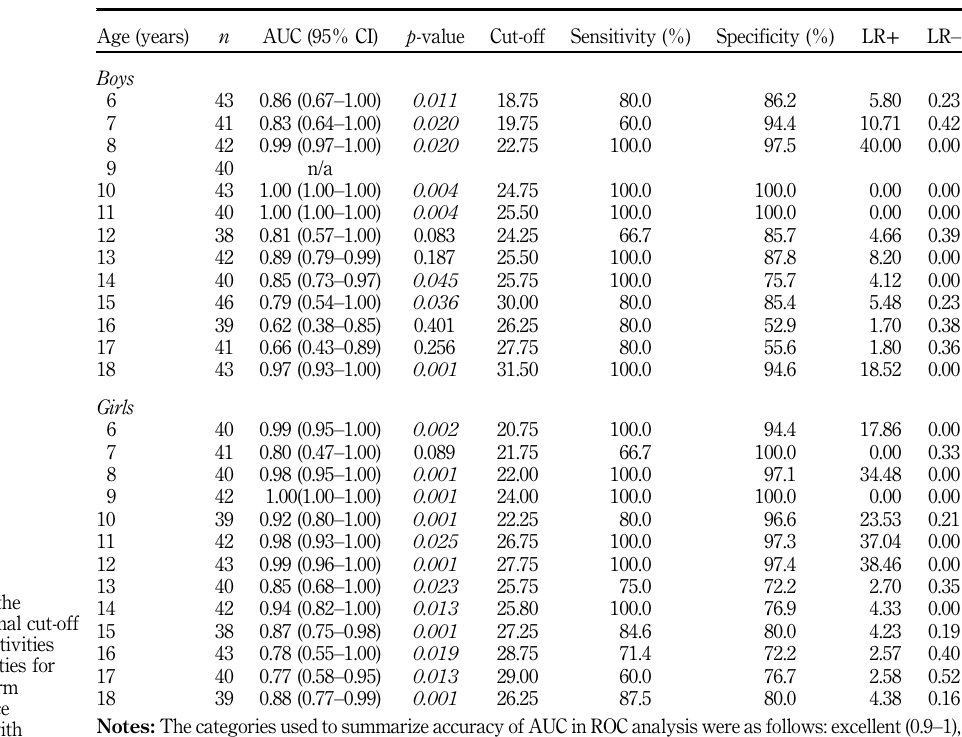
Table V. Area under the curves, optimal cut-off values, sensitivities and specificities for mid-upper arm circumference associated with overweight/obesity in boys and